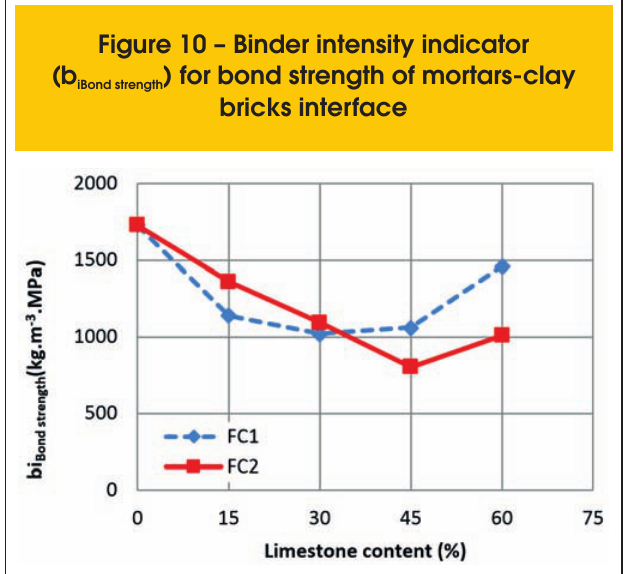
Figure 10 – Binder intensity indicator (b ) for bond strength of mortars-clay iBond strength bricks